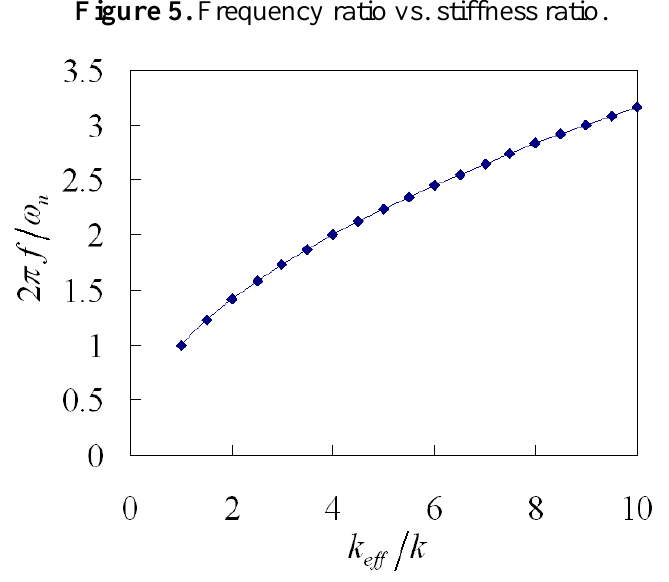
Figure 5. Frequency ratio vs. stiffness